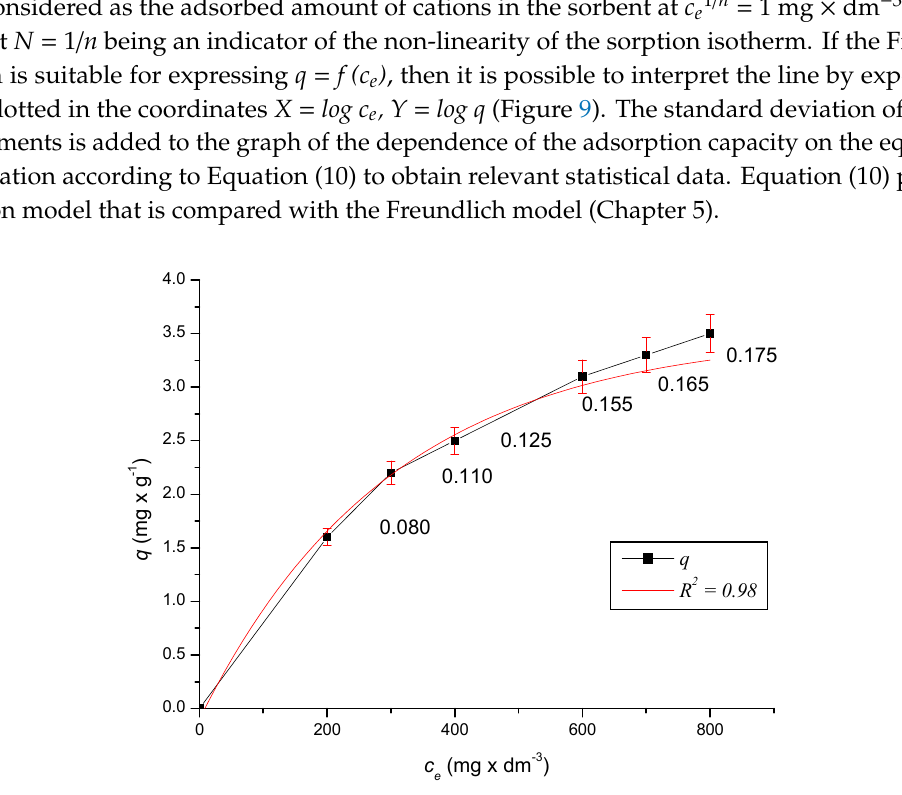
Figure 8. Dependence of adsorption capacity q on equilibrium concentration c e .